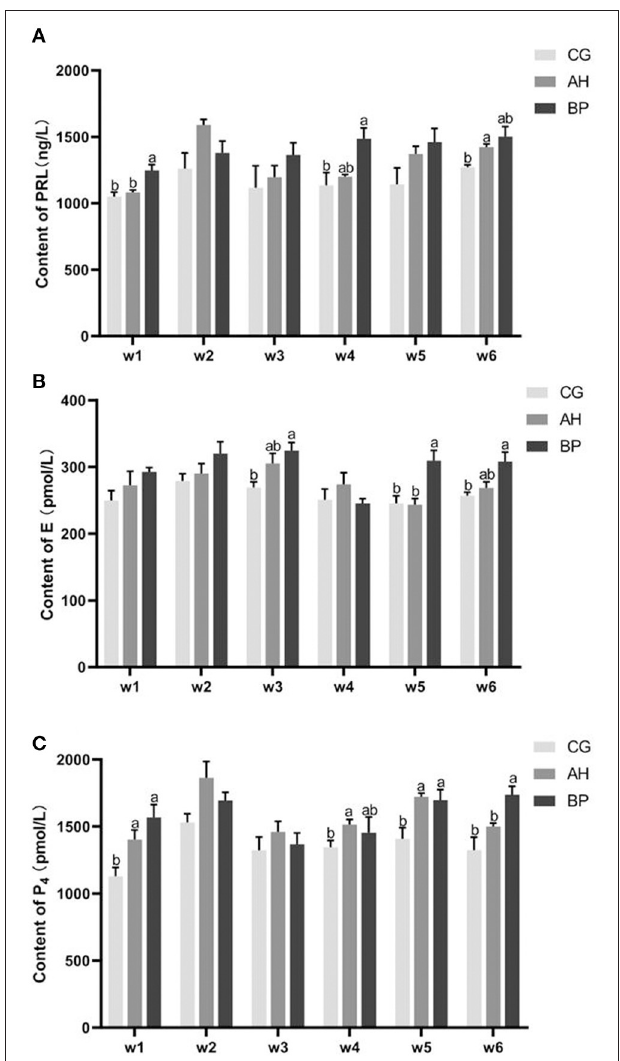
FIGURE 2 | The changes in related hormones during lactation. w1–w6 represents the 1st week to the 6th week. (A) PRL (prolactin); (B) E (estrogen); (C) P 4 (progesterone). Mean values without common superscript (a and b) differ significantly among CG, AH, and BP groups ( p < 0.05) and only represent the difference between different groups at the same time